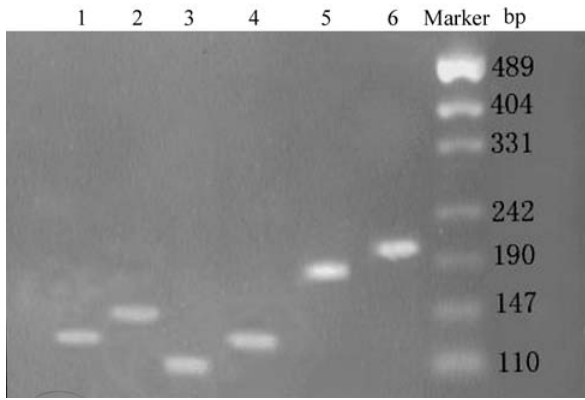
Figure 2 - Electrophoresis of the PCR products (after enzymatic diges- tion) on 3% (w/v) agarose gel. Lanes: 1 = rs# 2242480 Bam H I digestion product; 2 = undigested rs# 2242480; 3 = CYP3A4*6 EcoR I digestion product;lane4=undigestedCYP3A4*6;5=CYP3A4*1BHindIIIdiges- tion product; 6 = undigested